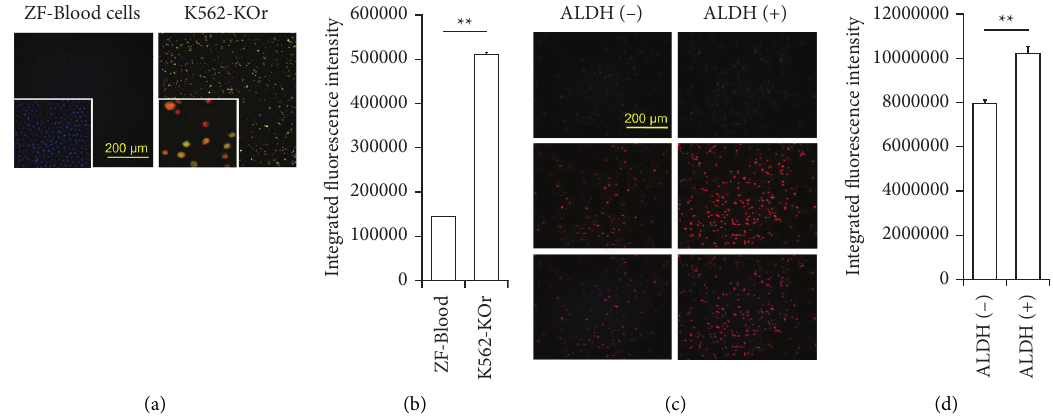
Figure 2: Selective staining on cancer cells, particularly on CSCs. (a) Representative images of zebrafish blood cells and K562-KOr cancer cells stained for 15min in 5 μ M compound exposure; blue: nucleus staining by Hoechst 33342; green: KOr expressed yellow fluorescence merged with the blue nucleus; red: the compound displayed red fluorescence. (b) Integrated fluorescence intensity of the compound staining on zebrafish blood cells and K562-KOr cancer cells. (c) ALDH( − ) and ALDH(+) cells of K562 cells were stained for 24h in 1 μ M compound exposure; blue: Hoechst 33342 for nucleus staining; red: the compound displayed red fluorescence. (d) Integrated fluorescence intensity of the compound staining on K562 ALDH( − ) and ALDH(+) cells.